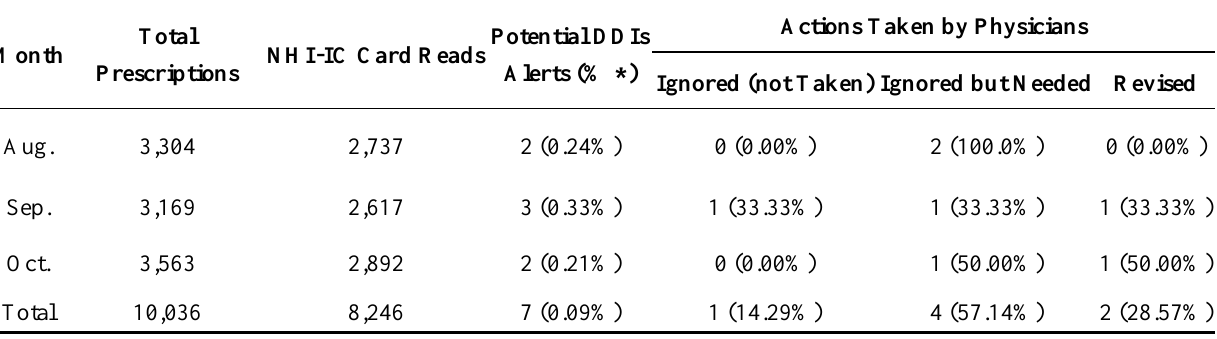
Table 2. The analysis of alerts and physicians’